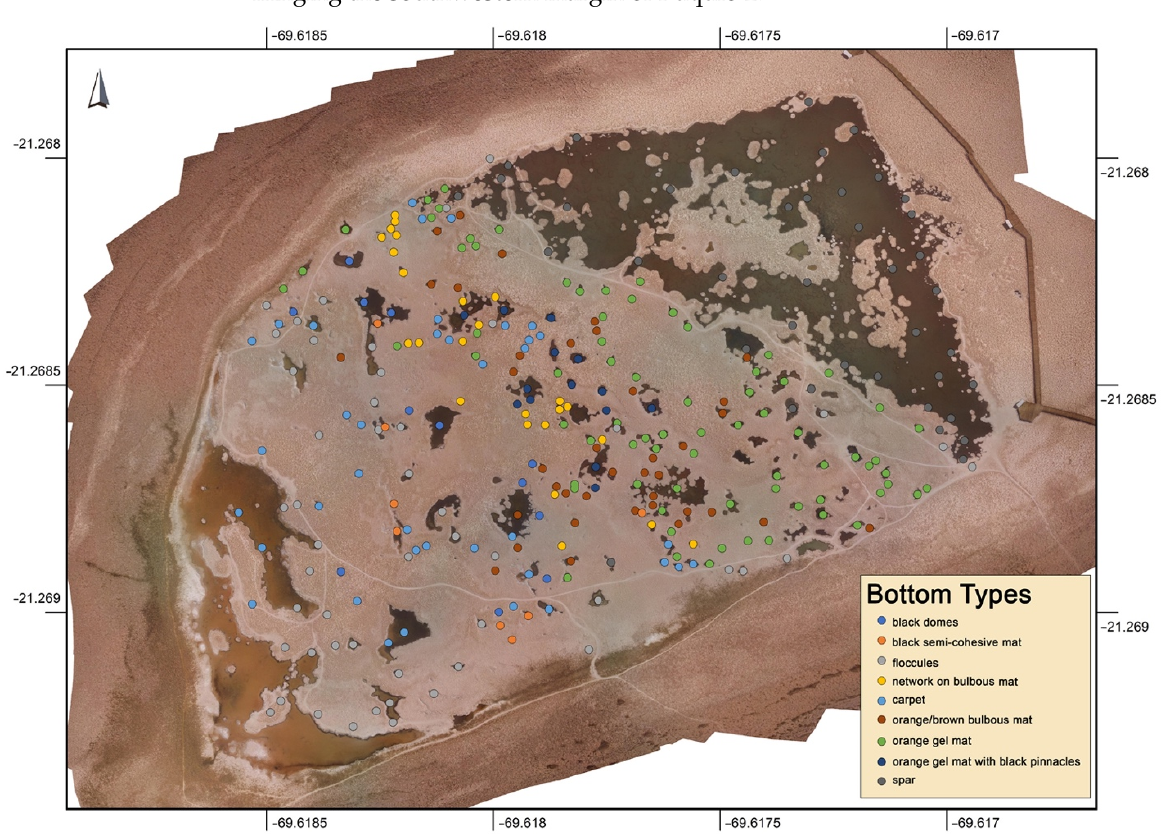
Figure 3. Map of bottom type locations recorded in March 2019 in the Puquio 1 and Puquio 2 system. Each colored dot represents a field observation.